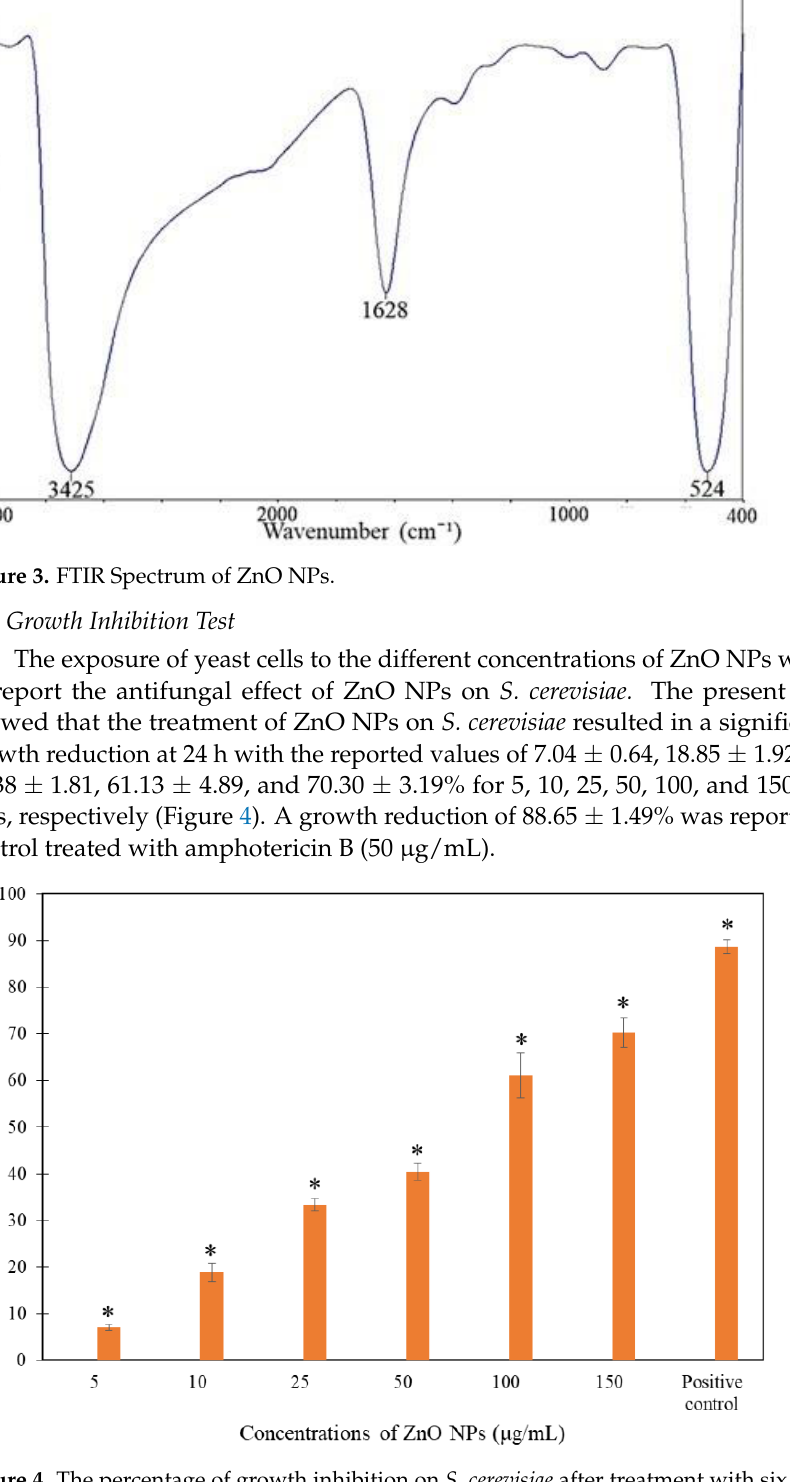
Figure 2. XRD analysis of ZnO NPs.